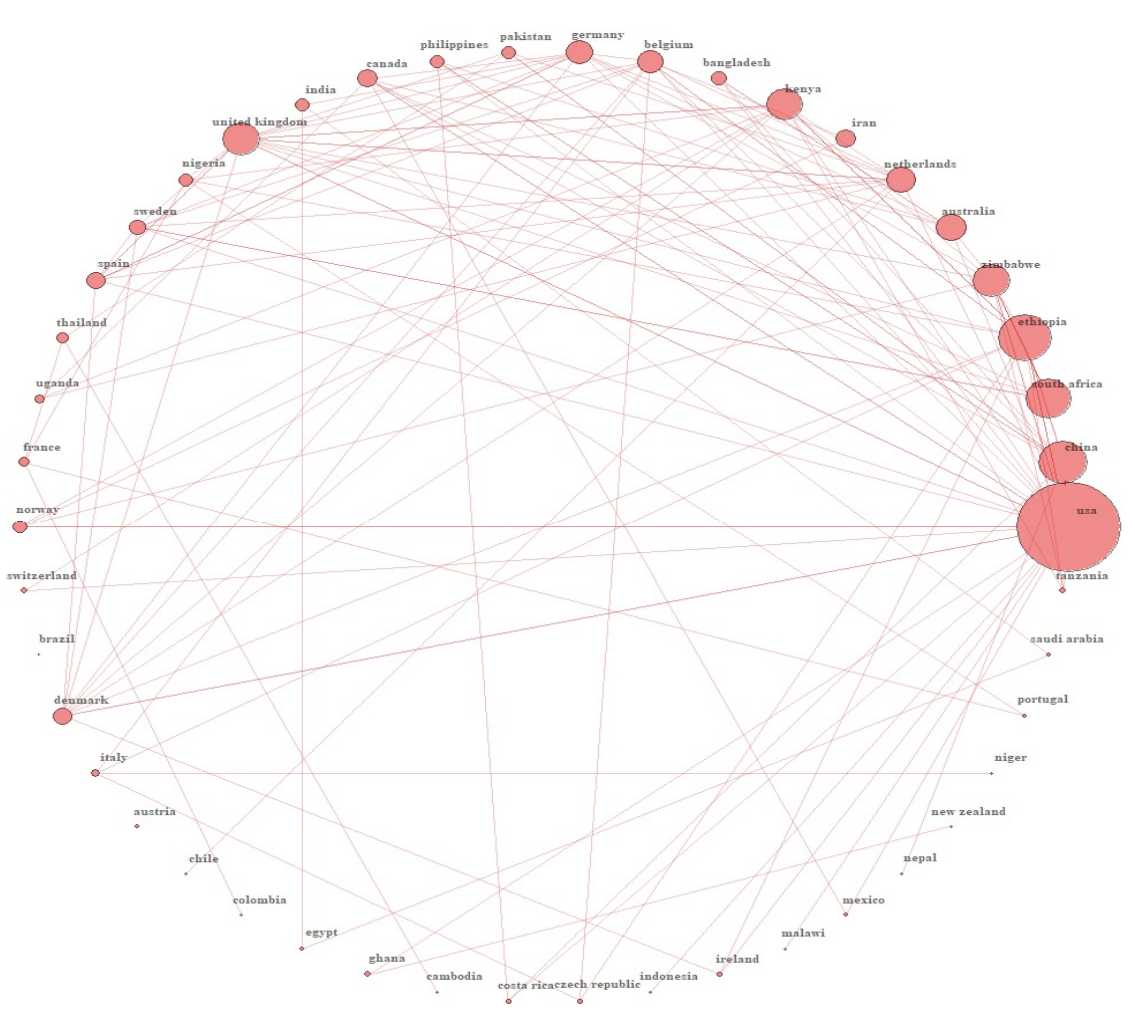
Figure 8. Countries’ collaboration networks on PASSFDR studies indexed in Scopus from 2011 to